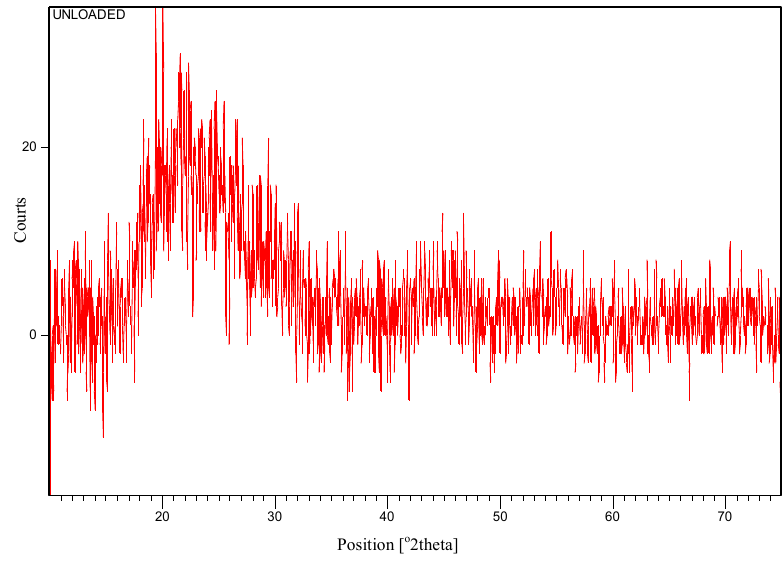
Figure 2. XRD Spectrum of